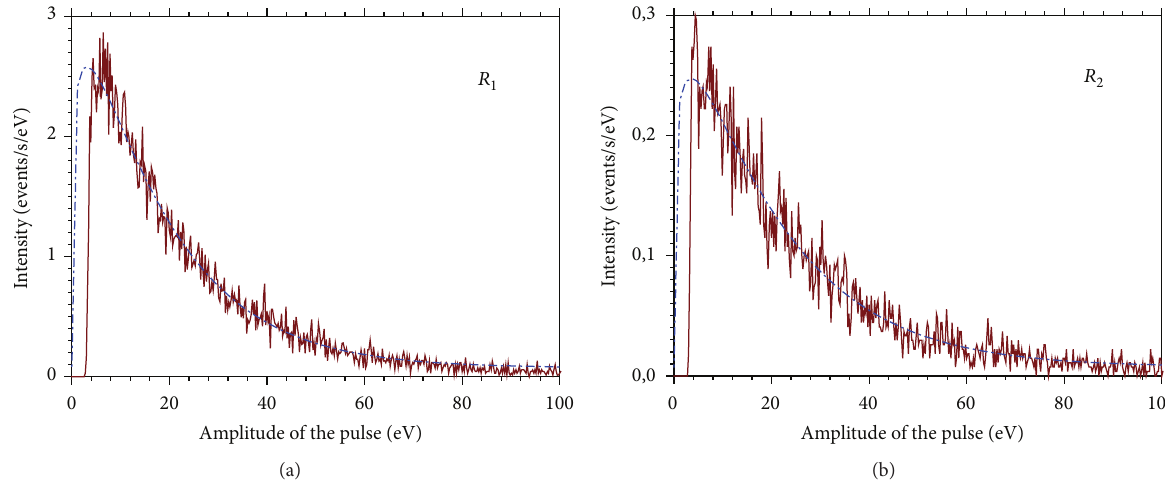
Figure 4: The single electron spectra obtained in measurements in 1st ( 𝑅 1 ) and 2nd ( 𝑅 2 ) configurations at the same flux of UV photons. The dashed curves indicate the Polya